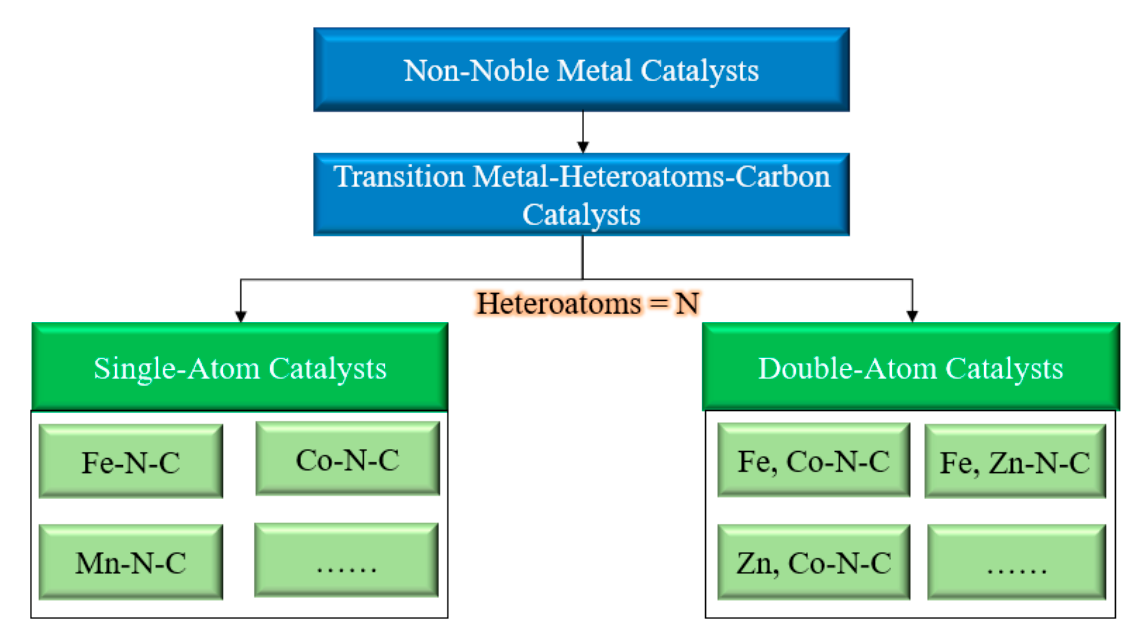
Figure 1. Scope and boundary of review.